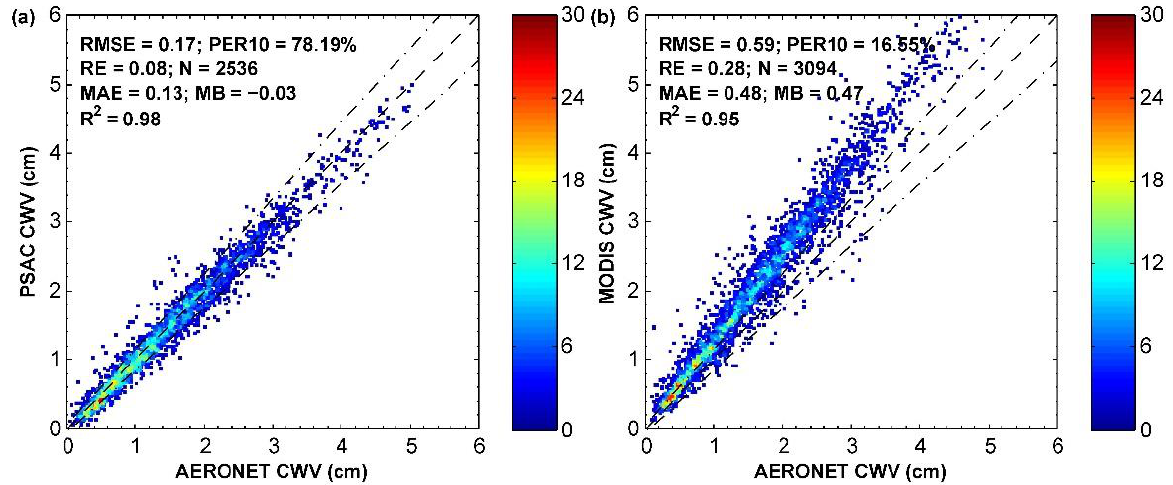
Figure 5. Scatter plots of the matching results between PSAC CWV data, MODIS CWV data, and AERONET data. ( a ) PSAC CWV data. ( b ) MODIS CWV data.